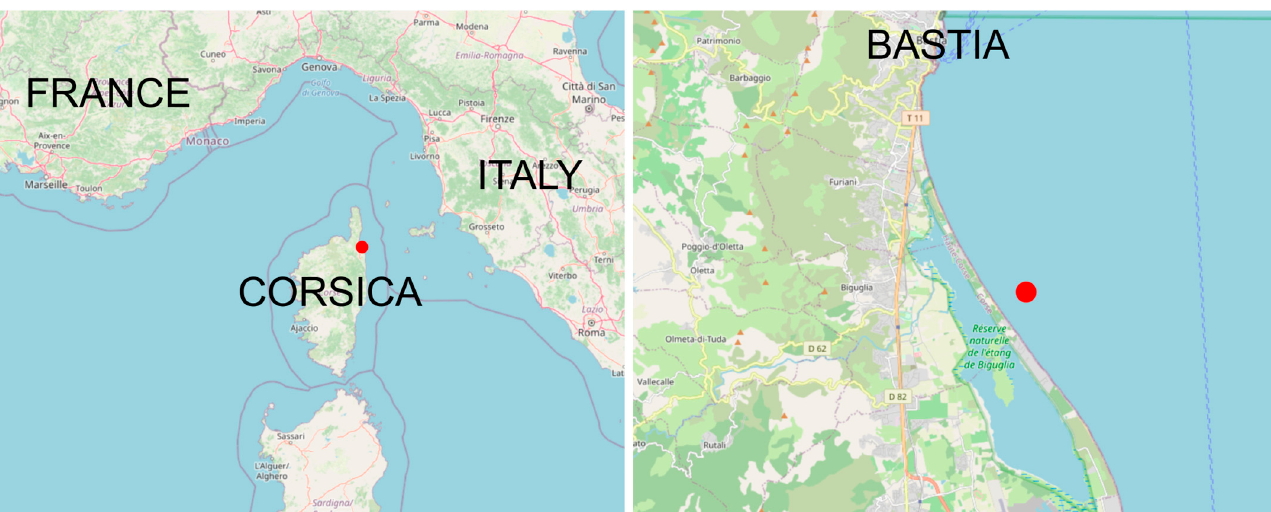
Figure 6. On the left, an illustrative diagram of the deployment of an acoustic receiver at sea. It shows how the different elements (mooring, buoys, receiver, signal flags, hydrophone, weights and ropes) are placed in relation to each other. On the right, a picture of a deployed receiver.